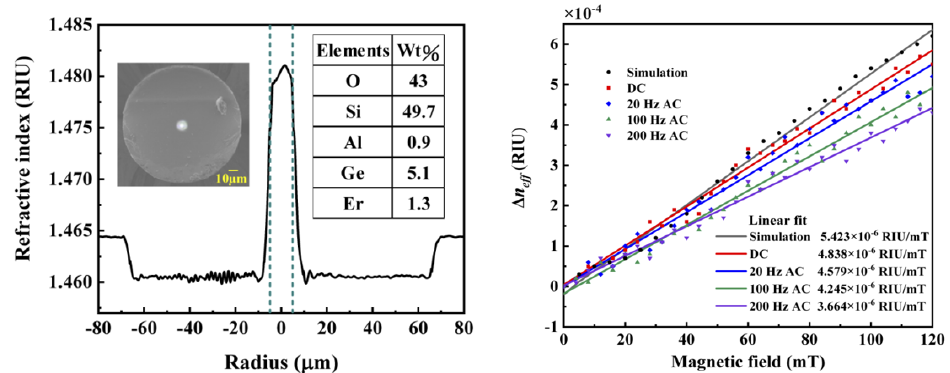
Figure 14. A relationship between the radius and refractive index, element contents in the core; and a relationship between magnetic field and ERI based on an EDF (reprinted with permission from Ref. [103], 2021, The Optical Society).